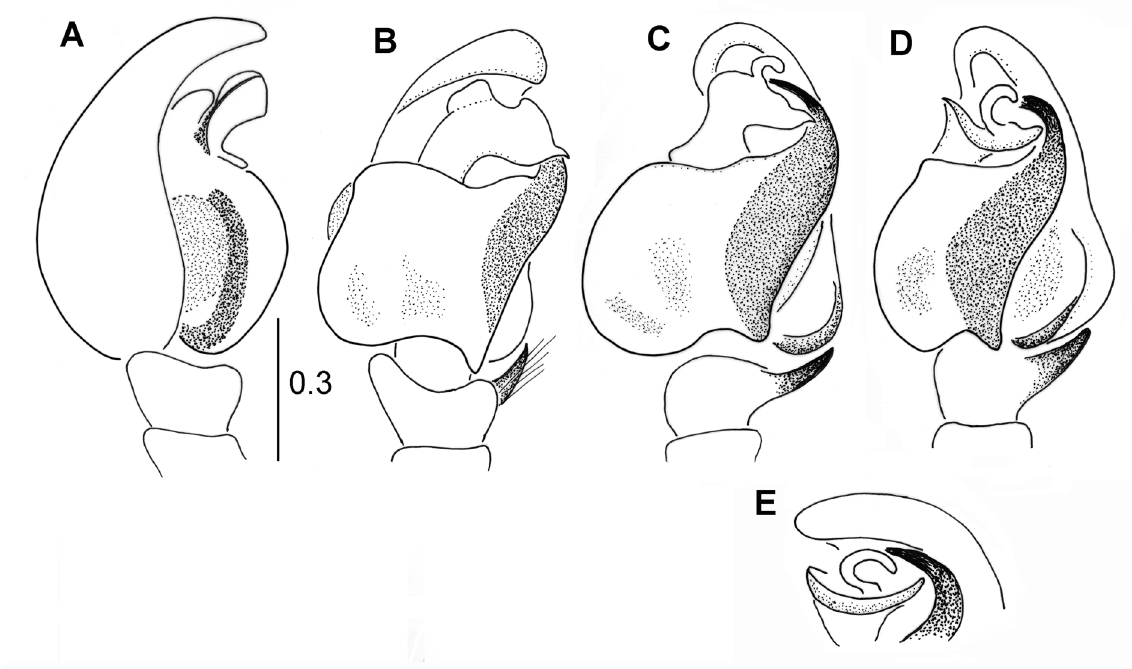
Fig. 57. Pulcherula magna gen. et sp. nov., holotype, ♂ (MNHN). A . Palpal organ, prolateral view. B . Palpal organ, ventral view. C . Palpal organ, ventroretrolateral view. D . Palpal organ, retrolateral view. E . Embolic